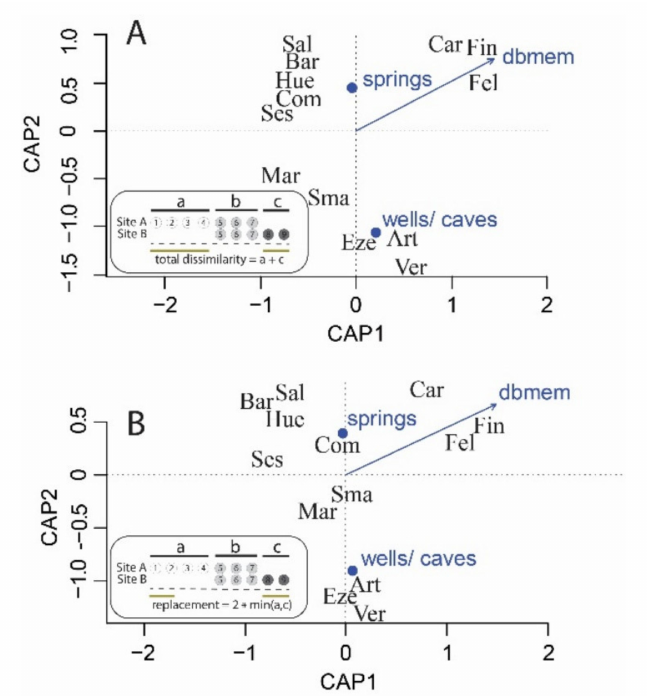
Figure 6. First two axes (canonical principal coordinates) of distance-based Redundancy Analysis of total dissimilarity ( A ) and species replacement ( B ) at diverse (> 10 stygobionts) Edwards and Edward-Trinity Aquifer sites. Blue circles are centroids for site types. dbmem is a distance-based Moran’s eigenvector map derived from latitude and longitude (UTM) of sites. Sal = Salado Springs, Bar = Barton Springs, Sma = San Marcos Artesian Well, Mar = San Marcos Springs, Ses = Sessom Creek Springs, Eze = Ezell’s Cave, Hue = Hueco Springs, Com = Comal Springs, Art = Artesia Pump Station Well #4, Ver = Verstraeten Well #1, Fel = San Felipe Springs, Fin = Finegan–Blue Springs, and Car = Caroline Springs. Insets are graphical representations of total dissimilarity and dissimilarity due to replacement, where numbers represent species (modified from Carvalho et al.